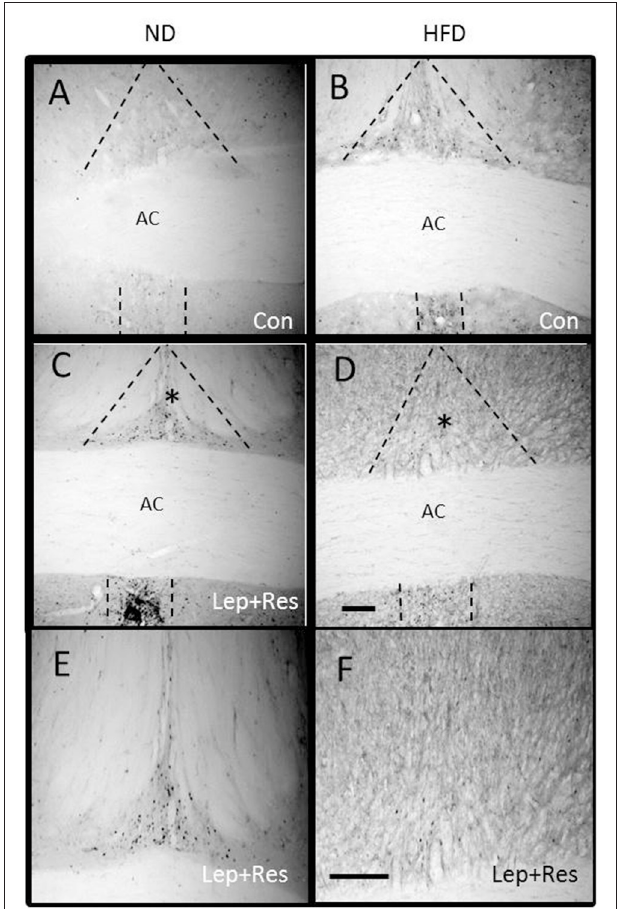
FIGURE 7 | Photomicrographs showing Fos-positive cell nuclei in the organum vasculosum of the lamina terminalis of rats fed a high fat diet (HFD) and rats fed a normal diet (ND) following centrally administered saline (5 µ l; control) or leptin combined with resistin (7 µ g). Scale bar = 100 µ m. The rostrocaudal levels of the sections counted were at ∼ 0.36–0.56mm rostral of bregma.